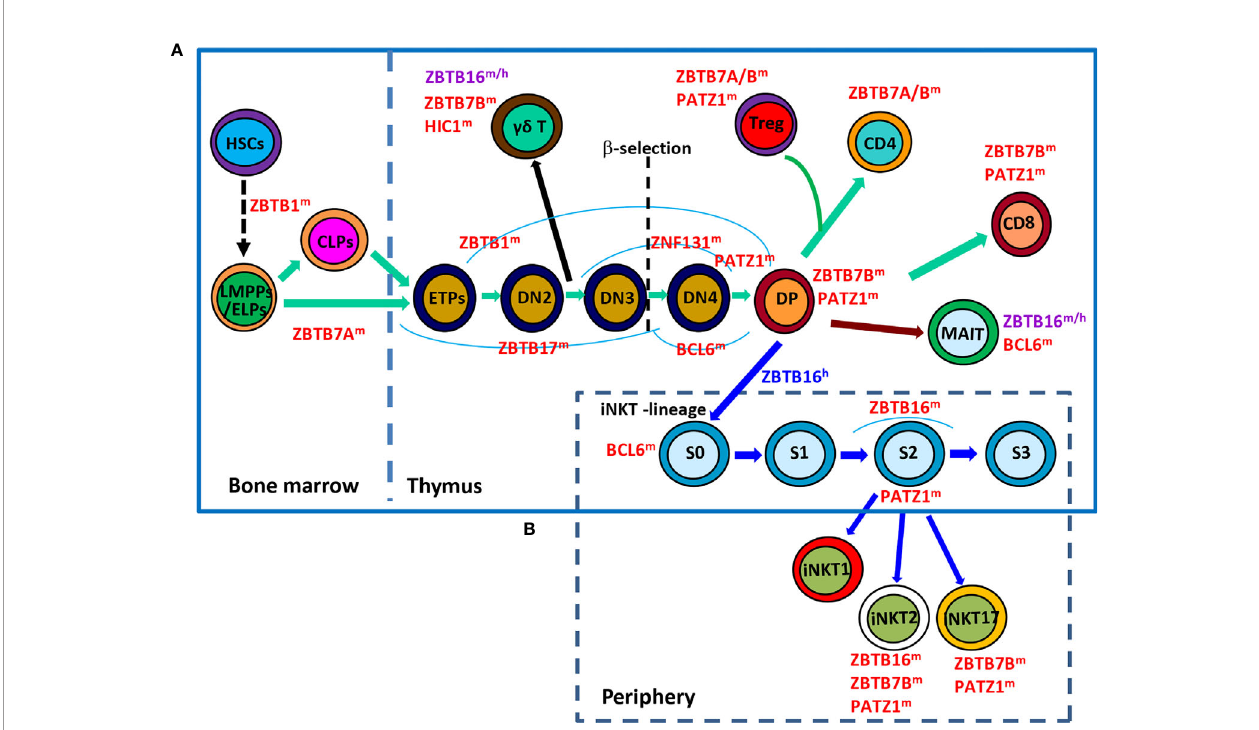
FIGURE 1 | Roles of ZBTB proteins in early T-cell development. (A), a schematic view of the stages most affected by ZBTB proteins along the early T-cell development program. ZBTB7A prevents the pre-mature differentiation of developing HSCs into DP T cells in the BM, while ZBTB1, ZBTB17, ZNF131, BCL6 and PATZ1 regulate the early development of conventional ab + T cells before the DP stage. Moreover, ZBTB16, ZBTB7B and HIC1 are important for the development/ function of g d + T cells which diverge from the conventional T-lineage program at the DN2 stage. Since the DP stage, PATZ1, ZBTB7B & ZBTB7A modulate the differentiation of conventional CD4/CD8 SP cells and Treg cells, whereas ZBTB16 and BCL6 promote the development of unconventional MAIT cell and iNKT cells from DP cells. (B) , a simpli fi ed overview of the development of iNKT cells in thymus as well as their functional maturation in the periphery. BCL6 promotes the transition of stage 0 (S0) iNKT cells into stage 1 (S1), after which ZBTB16 promotes their intrathymic expansion and effector differentiation. Moreover, PATZ1 and ZBTB7B fi ne-tune the subset differentiation of iNKT cells. ZBTB16 regulates iNKT cell development in humans as well. ZBTB proteins with the superscript ‘ m ’ , ‘ h ’ or ‘ m/h ’ in the upper right corner indicate that these proteins are ascribed to mice, humans or both, respectively. S,